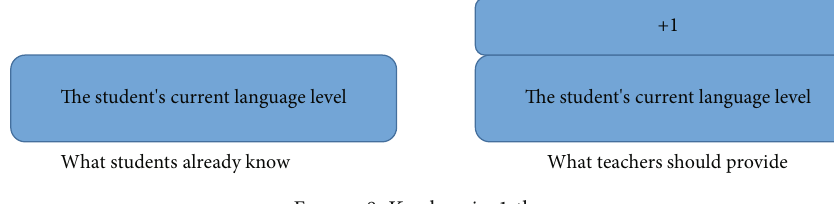
Figure 8: Krashen i + 1